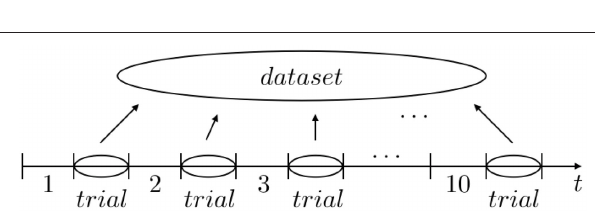
FIGURE 4 | Experimental paradigm of the ferret experiment. In the original recording protocol ( Sellers et al., 2013, 2015a,b), 10 visual stimuli are interleaved by several types of different stimuli, represented by numbers in the figure. Our dataset consists of the responses to sine-wave luminance gratings only. Other types of stimuli are the black screen (intervals marked by checkerboard noise for or fox images stimuli. The latter set consists of 2 , 7 { } the weakly spatially filtered image of foxes in the intervals marked by strongly spatially filtered image of foxes in the interval set